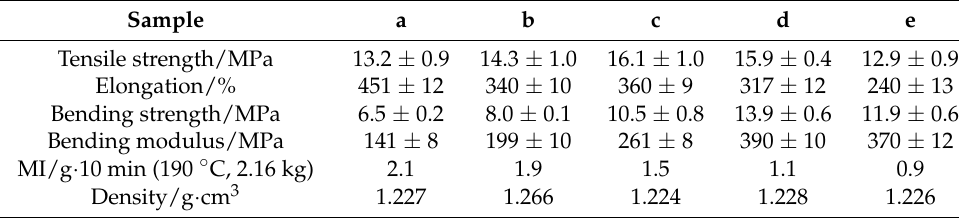
Table 4. Mechanical properties of the TPS/PBSA/PLA